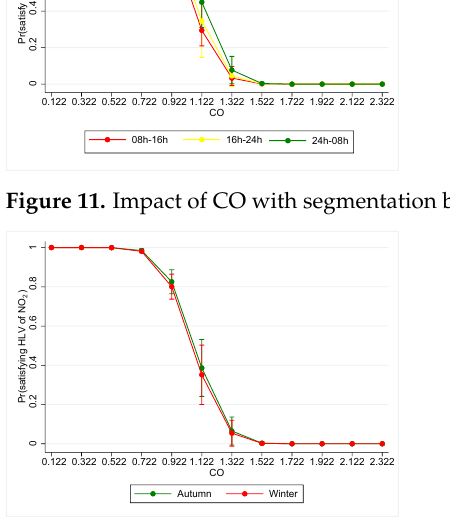
Figure 12. Impact of CO with segmentation by